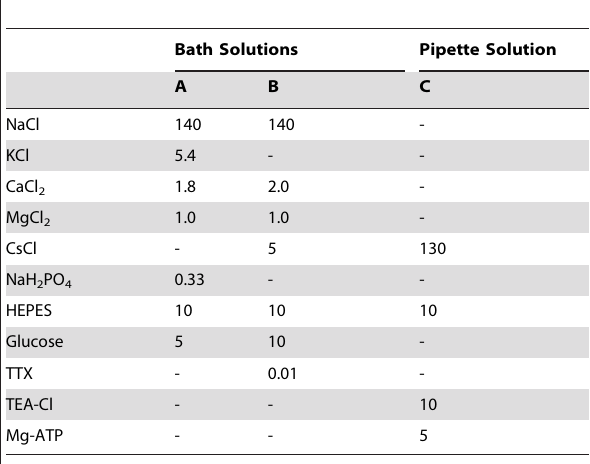
Table 1. Composition of solutions